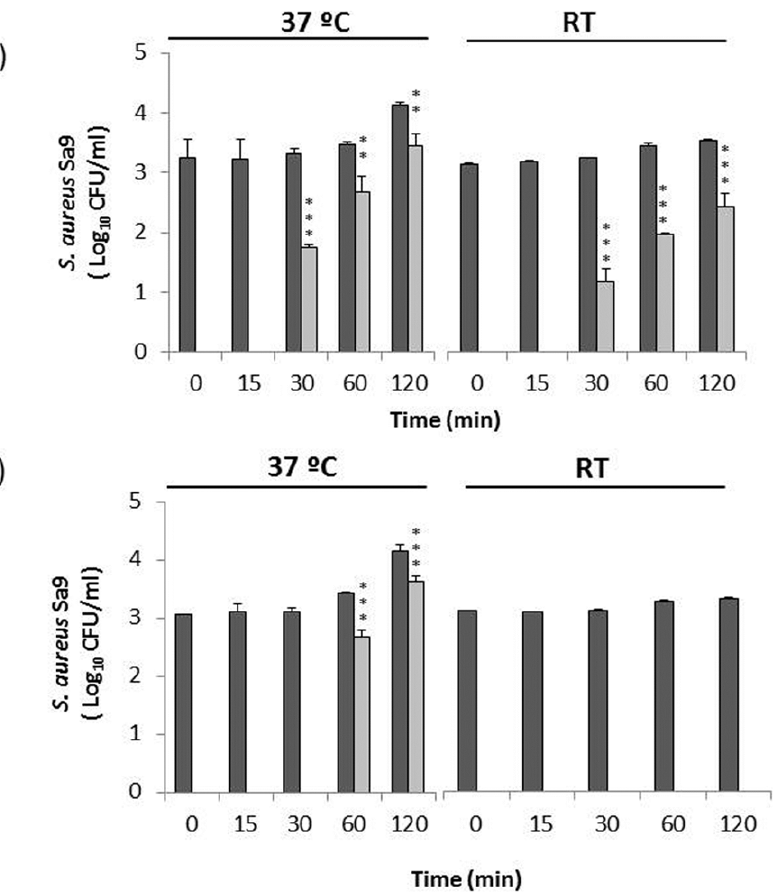
Figure 2. Antimicrobial activity of CHAPSH3b fusion protein in whole milk. Milk was inoculated with 10 3 CFU/ml of S. aureus Sa9 and incubated in the presence of 1.65 m M CHAPSH3b for 0, 15, 30, 60 and 120 min either at RT or 37 u C in: A) raw milk and B) pasteurized milk. Dark grey bars indicate S. aureus Sa9 control culture and light grey bars S. aureus Sa9 + CHAPSH3b. Values, expressed as log CFU/ml, are the means 6 standard deviations of two independent experiments. Bars having asterisks are significantly different from the control (** P , 0.01; *** P , 0.001). S. aureus detection threshold ( , 10 CFU/ml).